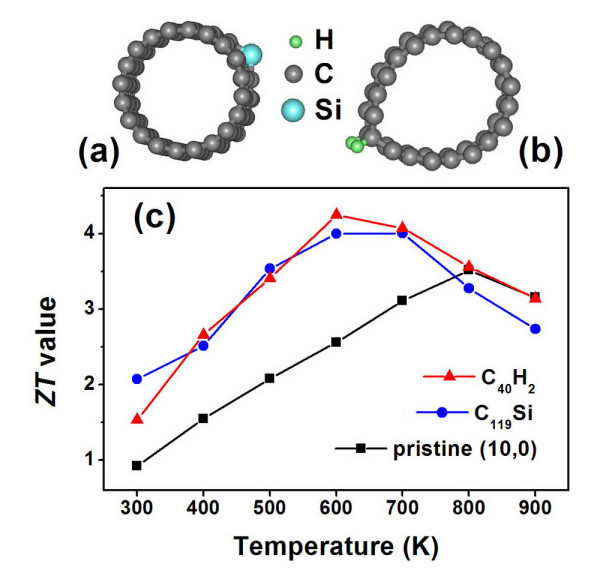
Fully relaxed structures and optimized ZT values of CNTs. Top view of the fully relaxed structures for (a) Si-doped (10,0) tube with nominal formula of C119Si and (b) the (10,0) tube chemisorbed with hydrogen atoms having nominal formula of C40H2. (c) Plots of the optimized ZT value as a function of temperature for theC119Si and C40H2 products, and the results for the pristine (10,0) tube is also shown for comparison.